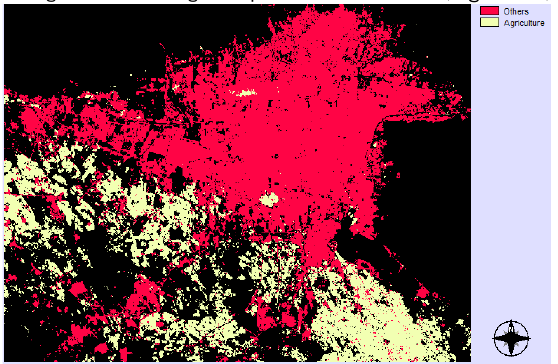
Figure 7. The predicted land use map of 2014 The results of the neural network show 91.17% accuracy for change extraction. The average of training and testing RMSE were 0.2507 and 0.2700 (Figure 8) respectively. The results of the RMSEs indicate the high ability and accuracy of neural network for modelling of agriculture. To validate the model, simulated land use map in 2014 was compared with the actual of classified satellite image of the same year. The calculated Kappa coefficient was 89.92 % that indicates the high capacity of the neural network and CA–Markov for simulation of agricultural changes in Tehran.